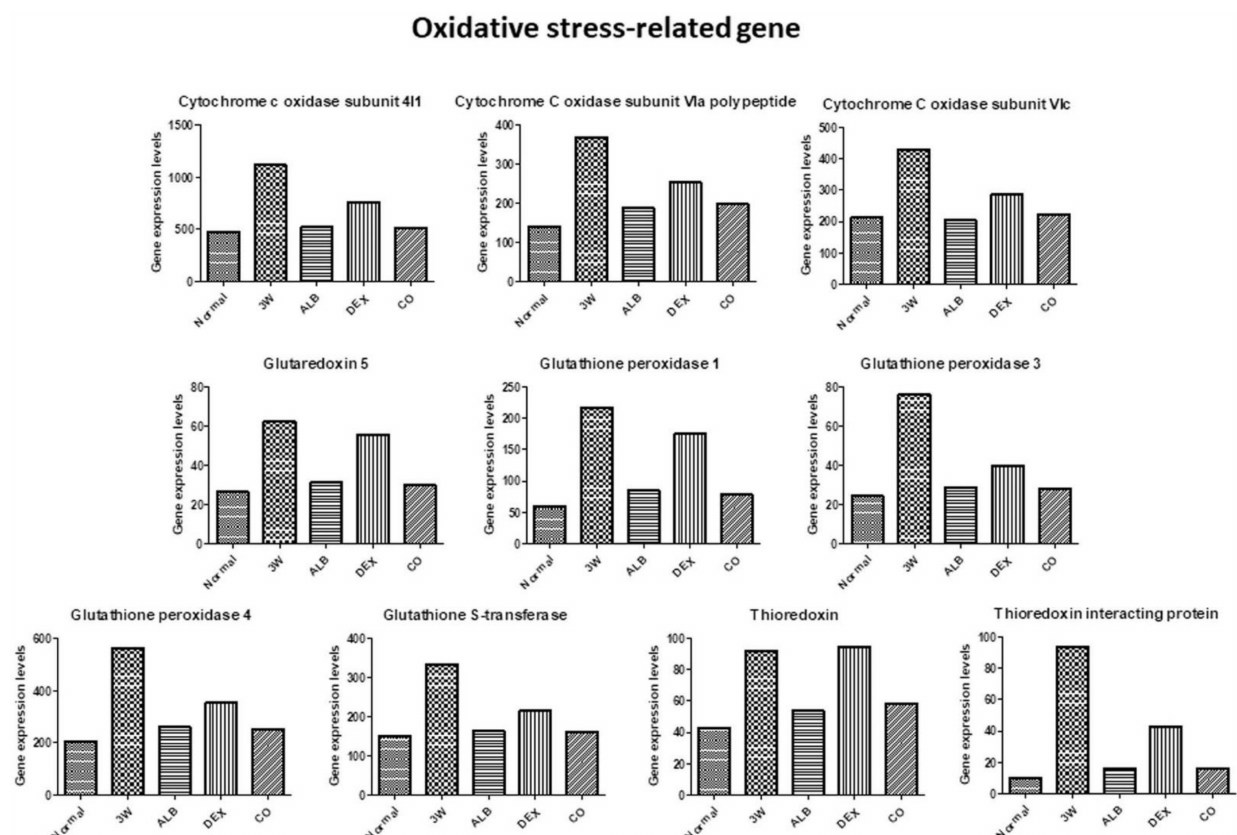
Figure 13. RNA-seq data of oxidative stress-related genes after treatment of albendazole alone dexamethasone alone, and co-therapy of the two drugs to BALB/c mice infected with Angiostrongylus cantonensis .